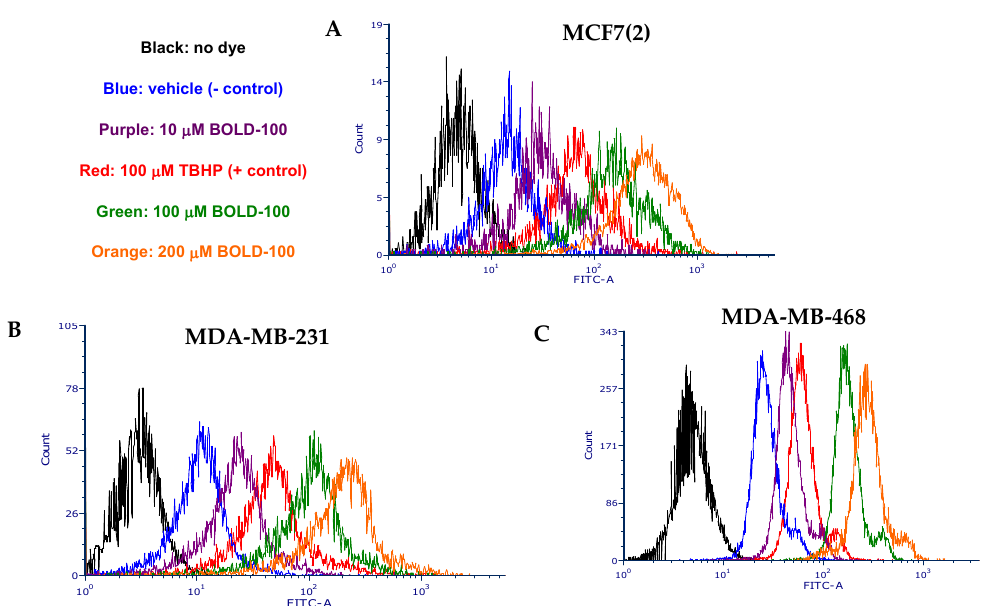
Figure 4. BOLD-100 induced ROS in breast cancer cells. Cell permeant reagent 2′,7′ – dichlorofluorescin diacetate (DCFDA) was used to measure cellular ROS activity (FITC-A, x-axis) in within cells (count, y-axis). BOLD-100 induced ROS increased in a dose-dependent manner in ( A ) MCF7(2), ( B ) MDA-MB-231 and ( C ) MDA-MB-468 cells. Negative control was the cells treated with vehicle (DMSO alone) and positive control was the cells treated with 100 μM Tert-Butyl Hydrogen Peroxide (TBHP) for 6 h.